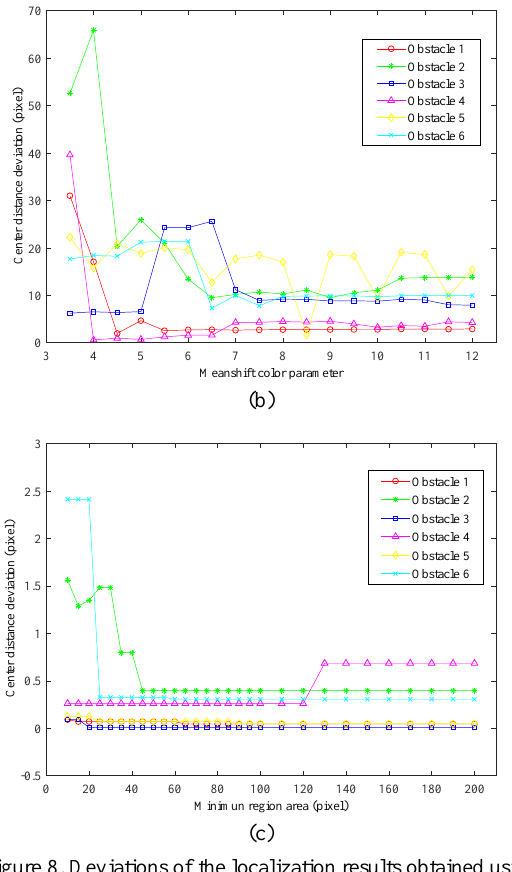
Figure 8. Deviations of the localization results obtained using different parameter settings: (a) window size; (b) color bandwidth; (c) minimum region